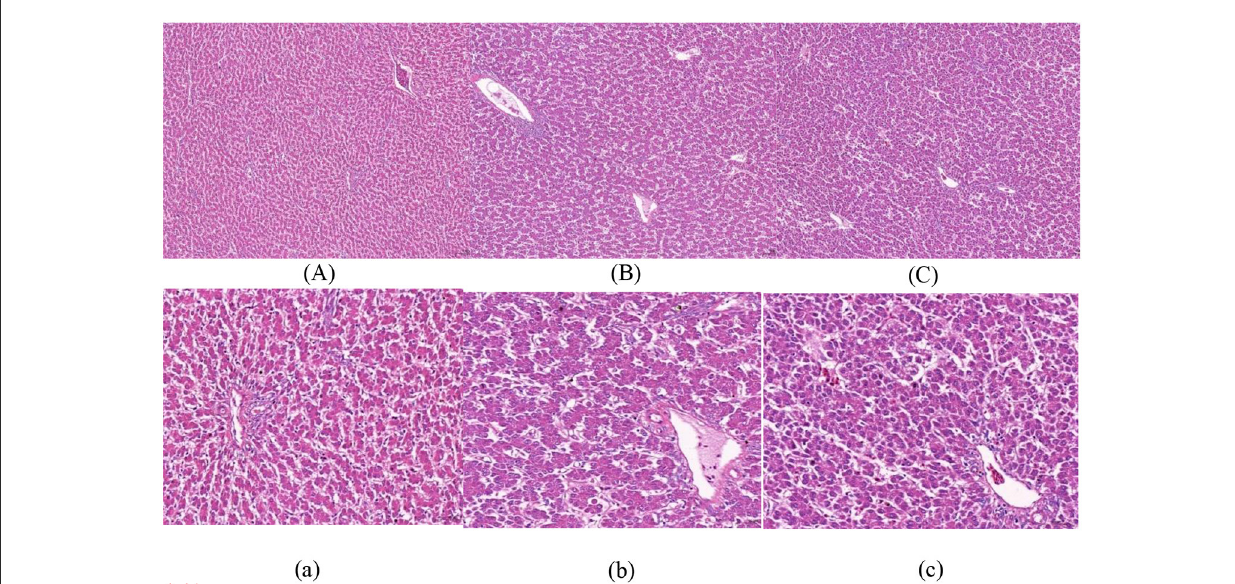
FIGURE3 The effect of non-fasting molting on liver tissue morphology (stage III). (A, a) Not treated with centralized molting; (B, b) fasting molting; (C, c) non-fasting molting. Upper-case letters are × 100, lower-case letters are × 400. Green arrows represent hepatocellular edema and blue arrows indicate the occurrence of steatosis.